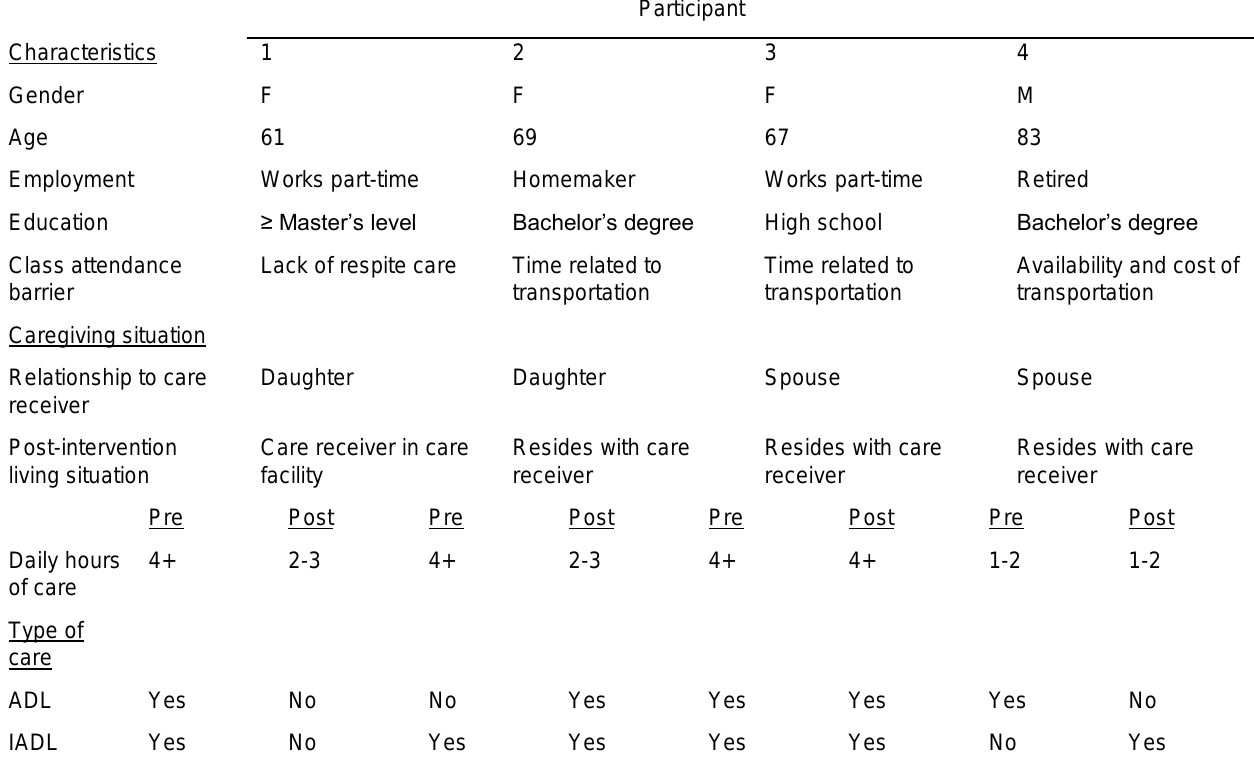
Table 1. Participant Demographics, Reported Barriers to Attending an In-Person Wellness Program, and Caregiving Situations